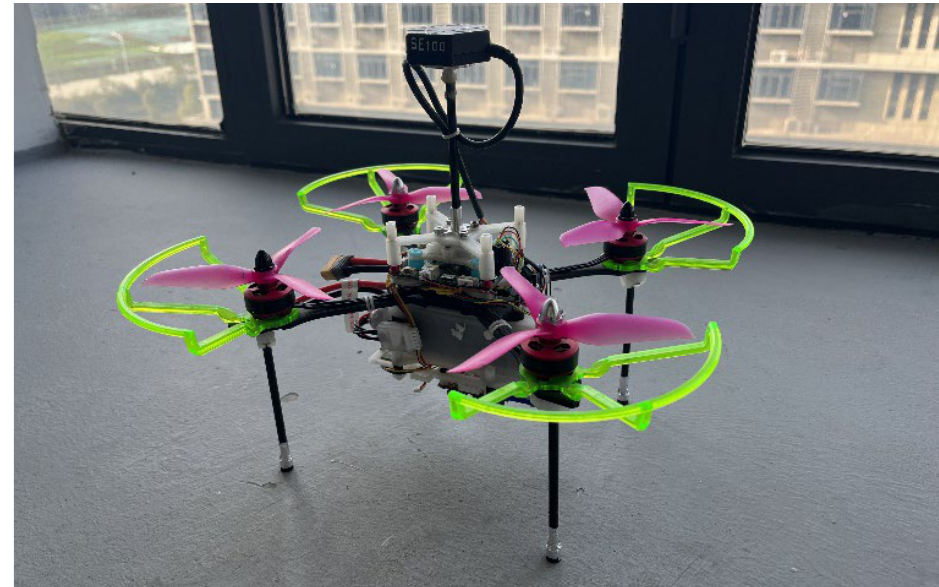
Figure 6. The structure of real quadrotor.